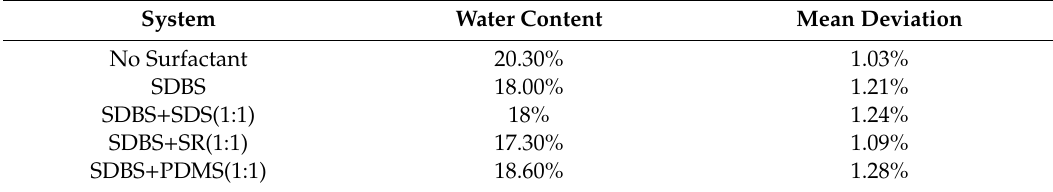
Table 9. of the species of surfactant on the leaching rate of phosphate rock.